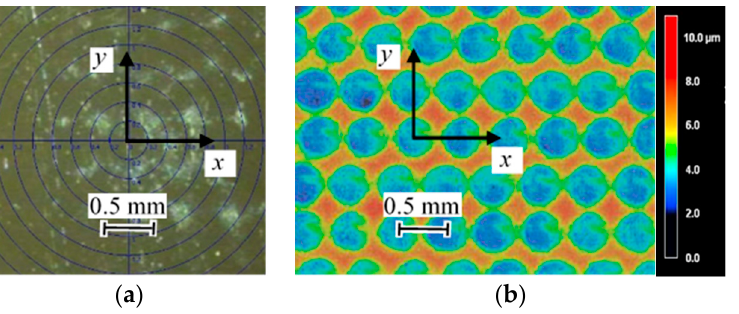
Figure 15. Aspects of the surface of the stainless-steel specimen treated by laser cavitation peening (specimen D); ( a ) observation using the CCD camera on the XRD system; ( b ) observations from the laser confocal microscope.